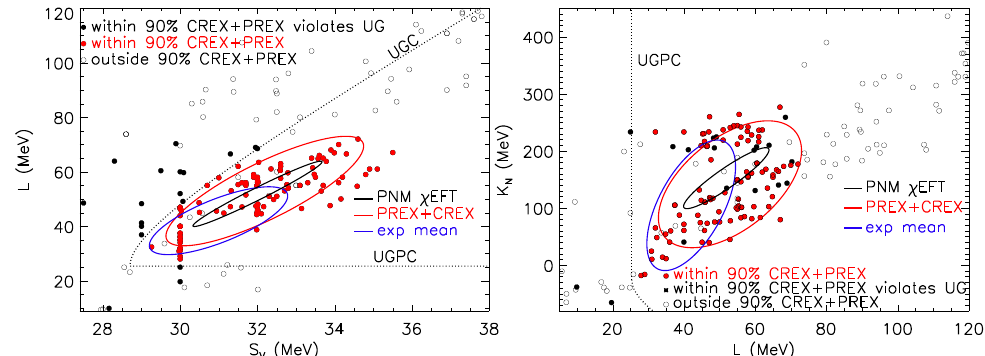
Figure 10. Symmetry parameters S V − L ( left panel ) and K N − L ( right panel ) jointly satisfying parity-violating experiments to within (exceeding) 90% confidence are shown as red and black filled (black open) circles; filled black circles violate Unitary Gas constraints (dotted boundary). Red (blue) confidence ellipses are for models satisfying Unitary Gas constraints weighted by their two-dimensional Gaussian probability defined by the parity-violating (red) and average (blue) experimental r 48 np and r 208 np measurements and uncertainties. The black confidence ellipse shows PNM χ EFT